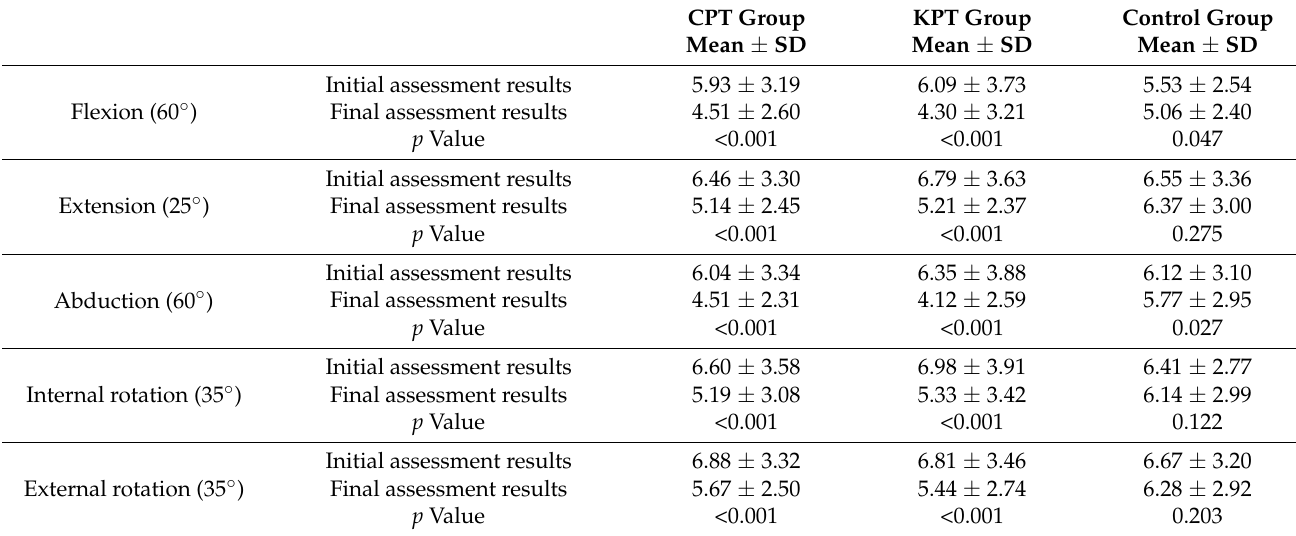
Table 3. Intra–group comparative analysis of the shoulder JPS.